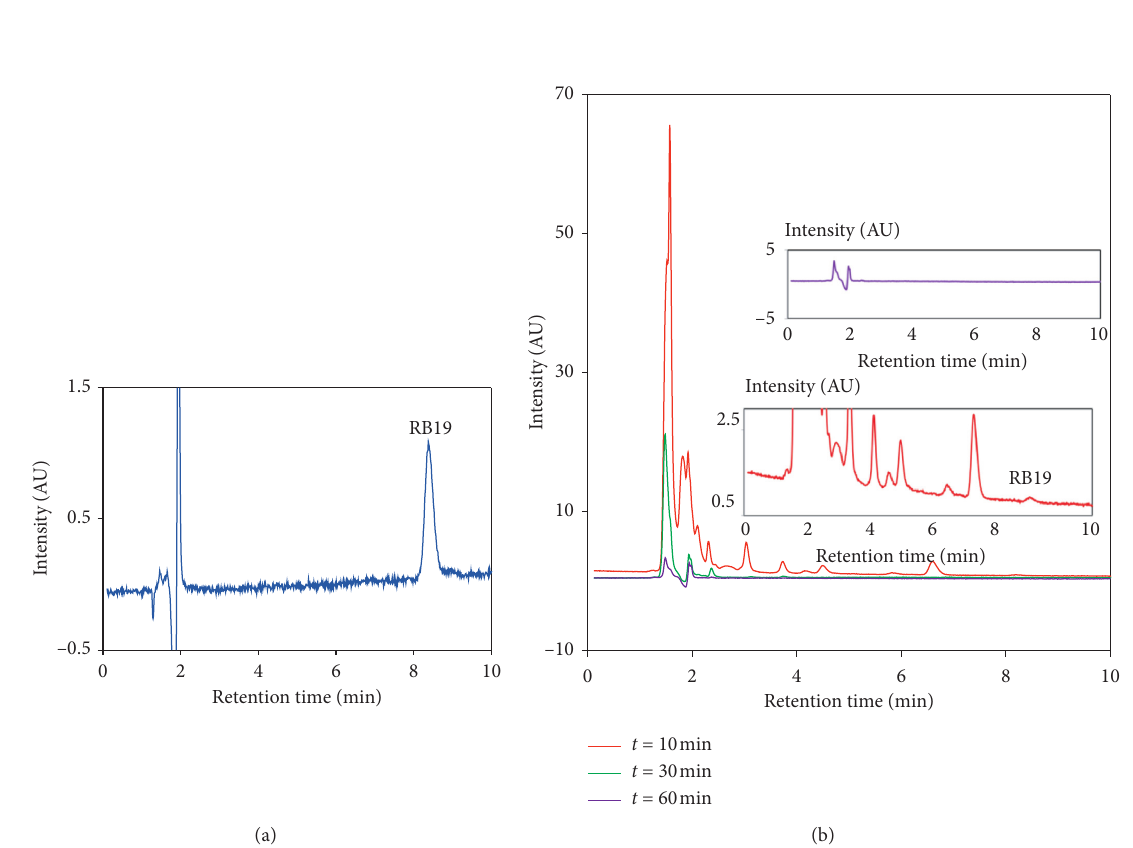
Figure 8: (a) The chromatogram of pure RB19 solution (1mg/L); (b) the chromatograms of the RB19 degradation solution by the H − Co 2 + system at different reaction times ( t � 10, 30, and 60min); the upper inset: the chromatogram recorded at a reaction time of HCO − 3 60min; the lower inset: zoom-in view of the chromatogram recorded at a reaction time of 10min.